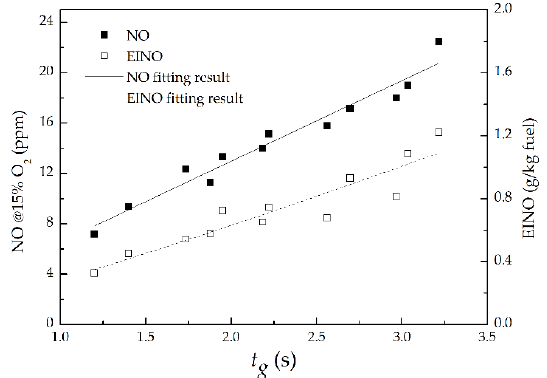
Figure 13. The NO and EINO for the global flame residence time.